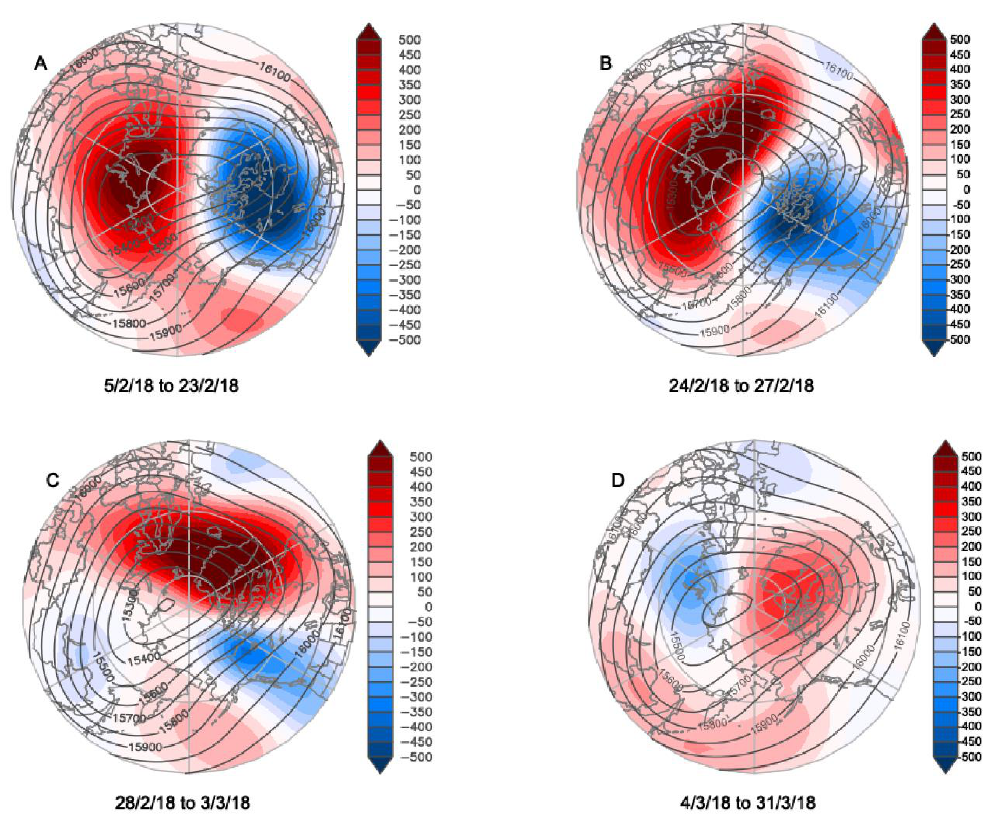
Figure 1. A 100 hPa geopotential height field (m, heights indicated by isolines and anomalies by color shadings relative to a 1981–2010 base period) for selected sub-periods from February–March 2018. Data are from NCEP–NCAR reanalysis.